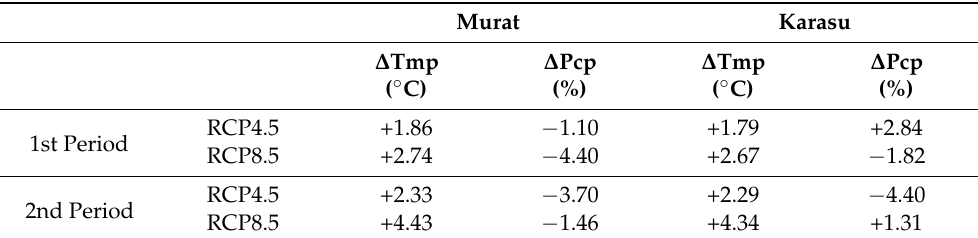
Table 11. Climate change data (temperature and precipitation) for each basin. Murat Karasu ∆